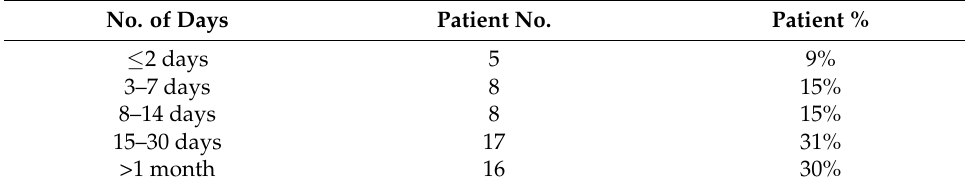
Table 2. Time from admission to positive culture.